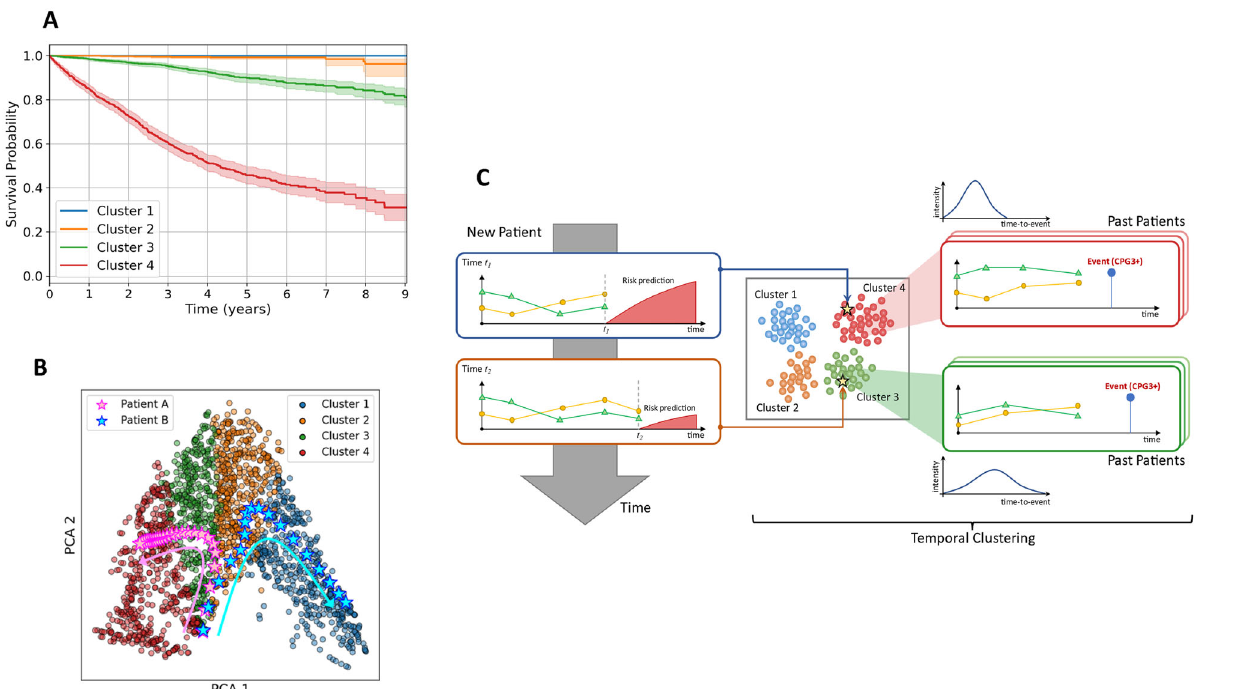
Fig. 3 Description of the risk prediction and temporal clustering outputs and trajectories generated. A Kaplan Meier plot of the survival distributions and con fi dence intervals for the 4 temporal phenotypic clusters identi fi ed from the DDHL model showing the different rates of progression to Cambridge Prognostic Group 3 (CPG3) event over time. B Same temporal clusters represented in the space of the two principal components (PCA) of the latent embeddings (each point corresponds to a sampled patient). Trajectories of two illustrative example patients A and B also shown: A deteriorates as more observations are collected, moving from Cluster 3 to 4, while B improves, moving from Cluster 2 to 1. C A schematic illustrating the risk prediction and temporal clustering aspects of the DDHL model. (Right-hand side) Hypothetical Clusters 3 and 4 are illustrated to show the sets of past patients assigned to them in training. Cluster 4 is presented to contain higher risk patients; hence the histogram indicates an overall earlier time-to-event among these patients. Cluster 3 is presented to contain relatively lower risk patients, hence the histogram peaks at a later time-to-event. (Left-hand side) A hypothetical patient ’ s progression: at time t1 the patient has a comparatively steep risk prediction curve (red slope), and the model assigns him to Cluster 4; as more observations are made at time t2, the risk pro fi le is lowered, patient is now in Cluster